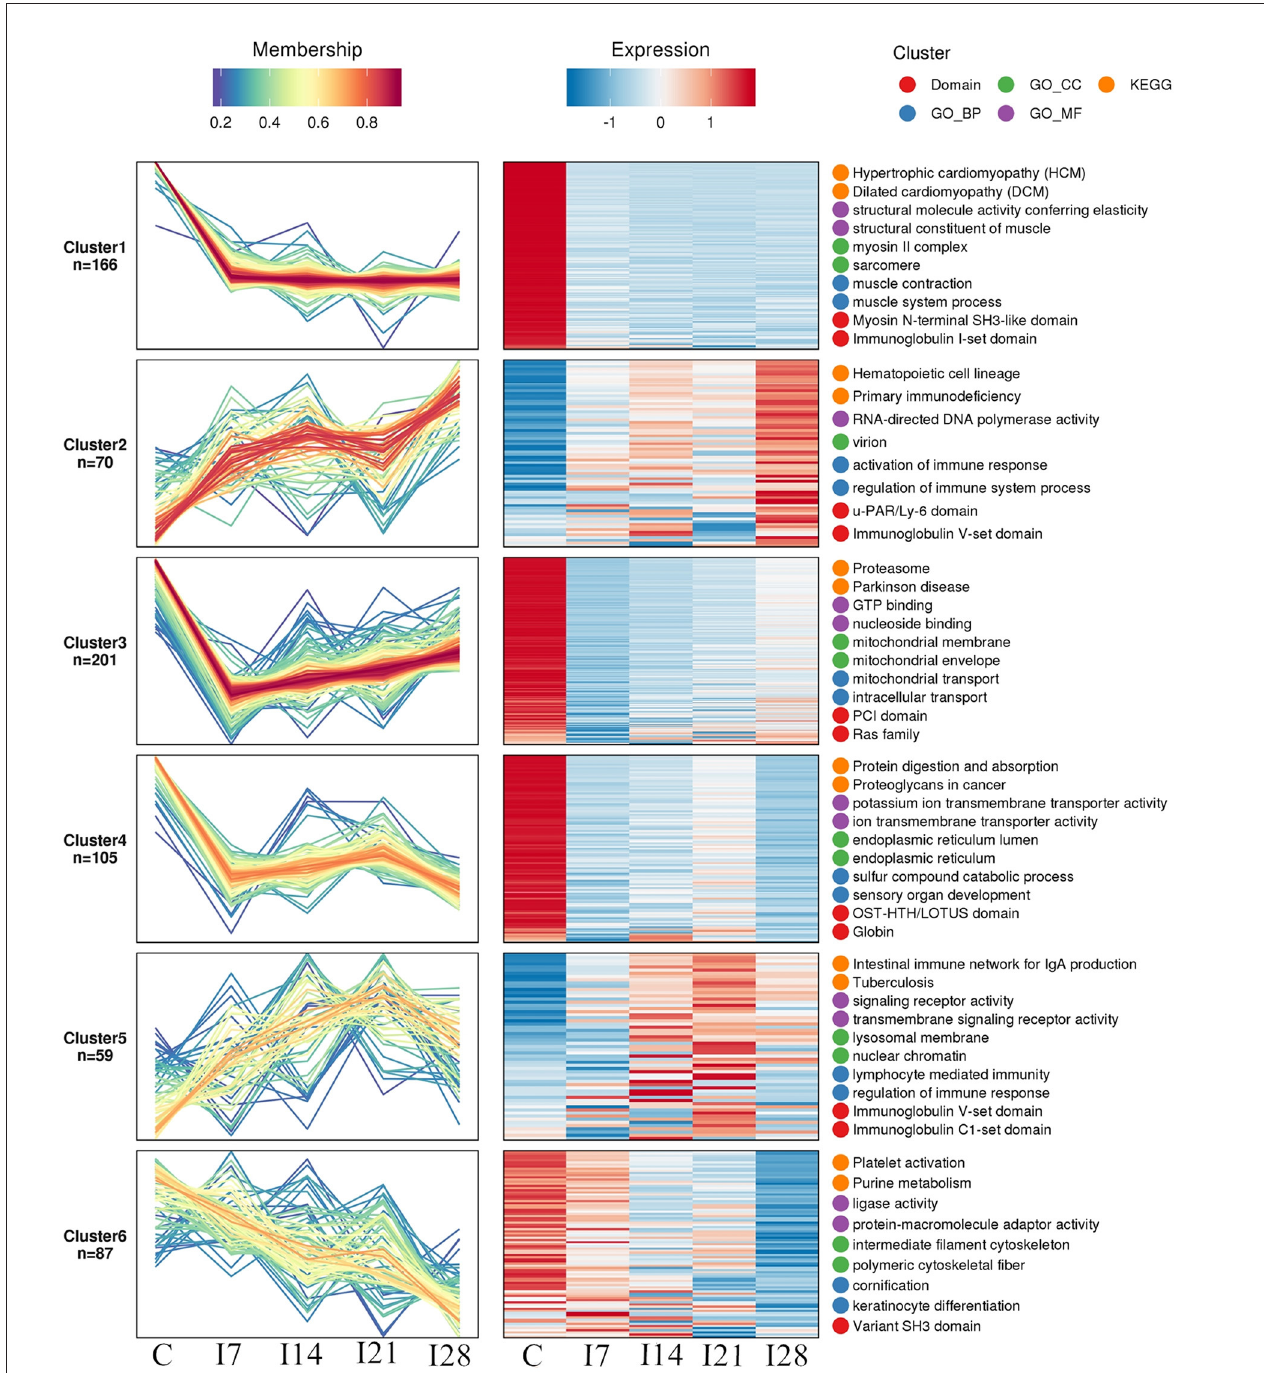
FIGURE 5 | Functional clustering of differentially expressed proteins. All time profiles were clustered by a fuzzy clustering algorithm to determine modules of co-regulated proteins. The first two most significantly enriched entries in the Gene Ontology (GO)/Kyoto Encyclopedia of Genes and Genomes (KEGG)/Domain enrichment analysis are displayed on the right side of the corresponding cluster expression pattern clustering